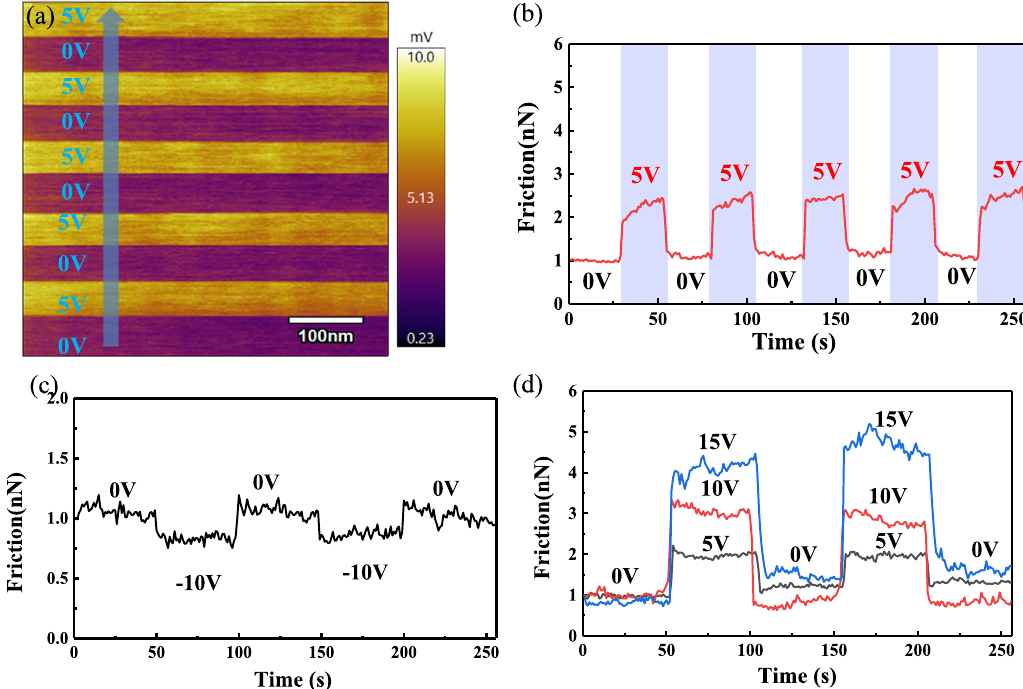
Fig. 8 Nanofriction modulation on atomically thin MoS 2 . a Mapping of the nanofriction on atomically thin MoS 2 modulated dynamically under different V g . Scale bar: 100 nm. b Corresponding pro fi les of the nanofriction indicated by the blue arrow line. c The nanofriction on atomically thin MoS 2 modulated by applying the negative V g . d The nanofriction on atomically thin MoS 2 modulated by applying different positive V g (the load for friction test was 10